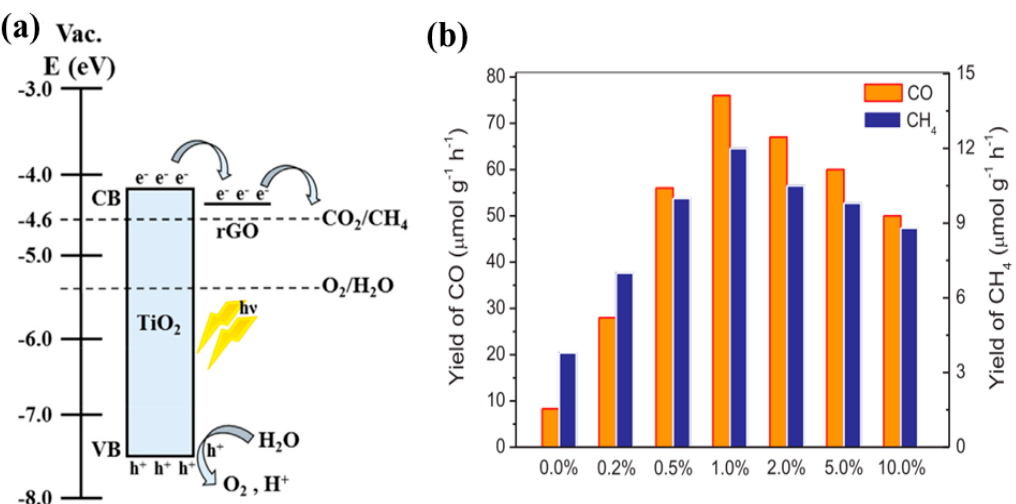
Figure 5. ( a ) Schematic view of photocatalytic conversion of CO 2 into CH 4 on rGO-TNT (taken with permission from [30]). ( b ) Production rate of CO and CH 4 from GR-TNR with varied concentrations of graphene (taken with permission from [60]).